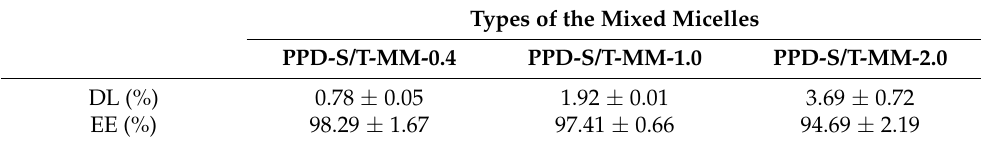
Table 3. Drug loading and encapsulation efficiency of PPD-S/T-MM (Mean ± SD, n = 3). Types of the Mixed Micelles PPD-S/T-MM-0.4 PPD-S/T-MM-1.0